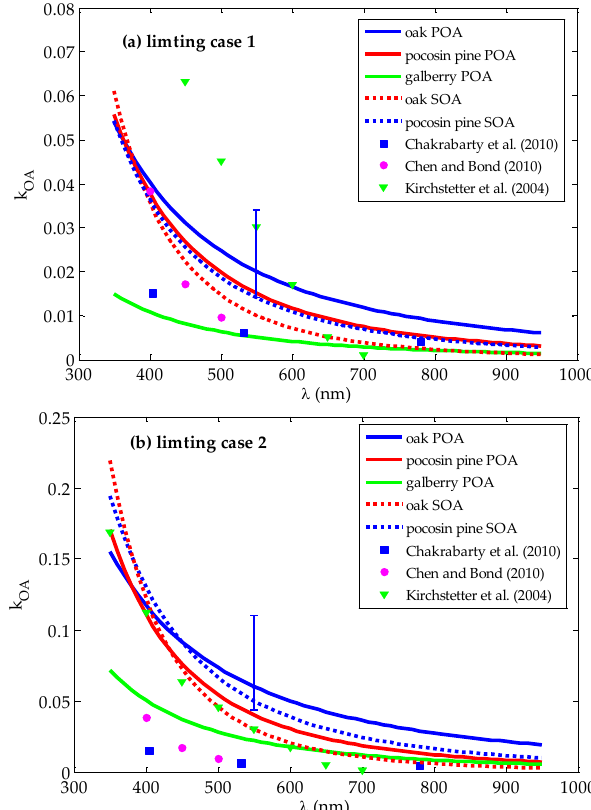
Fig. 6. Estimated imaginary part of the refractive indices of POA and SOA for the fuels investigated in this study for (a) limiting case 1 (external-mixing assumption) and (b) limiting case 2 (core-shell assumption). The blue error-bars represent the uncertainty in k OA of oak POA at λ = 550nm; other fuels exhibit similar relative uncer- tainties. Also shown here are k OA values of biomass-burning emis- sions reported by previous studies (see Sect. 4.2 for